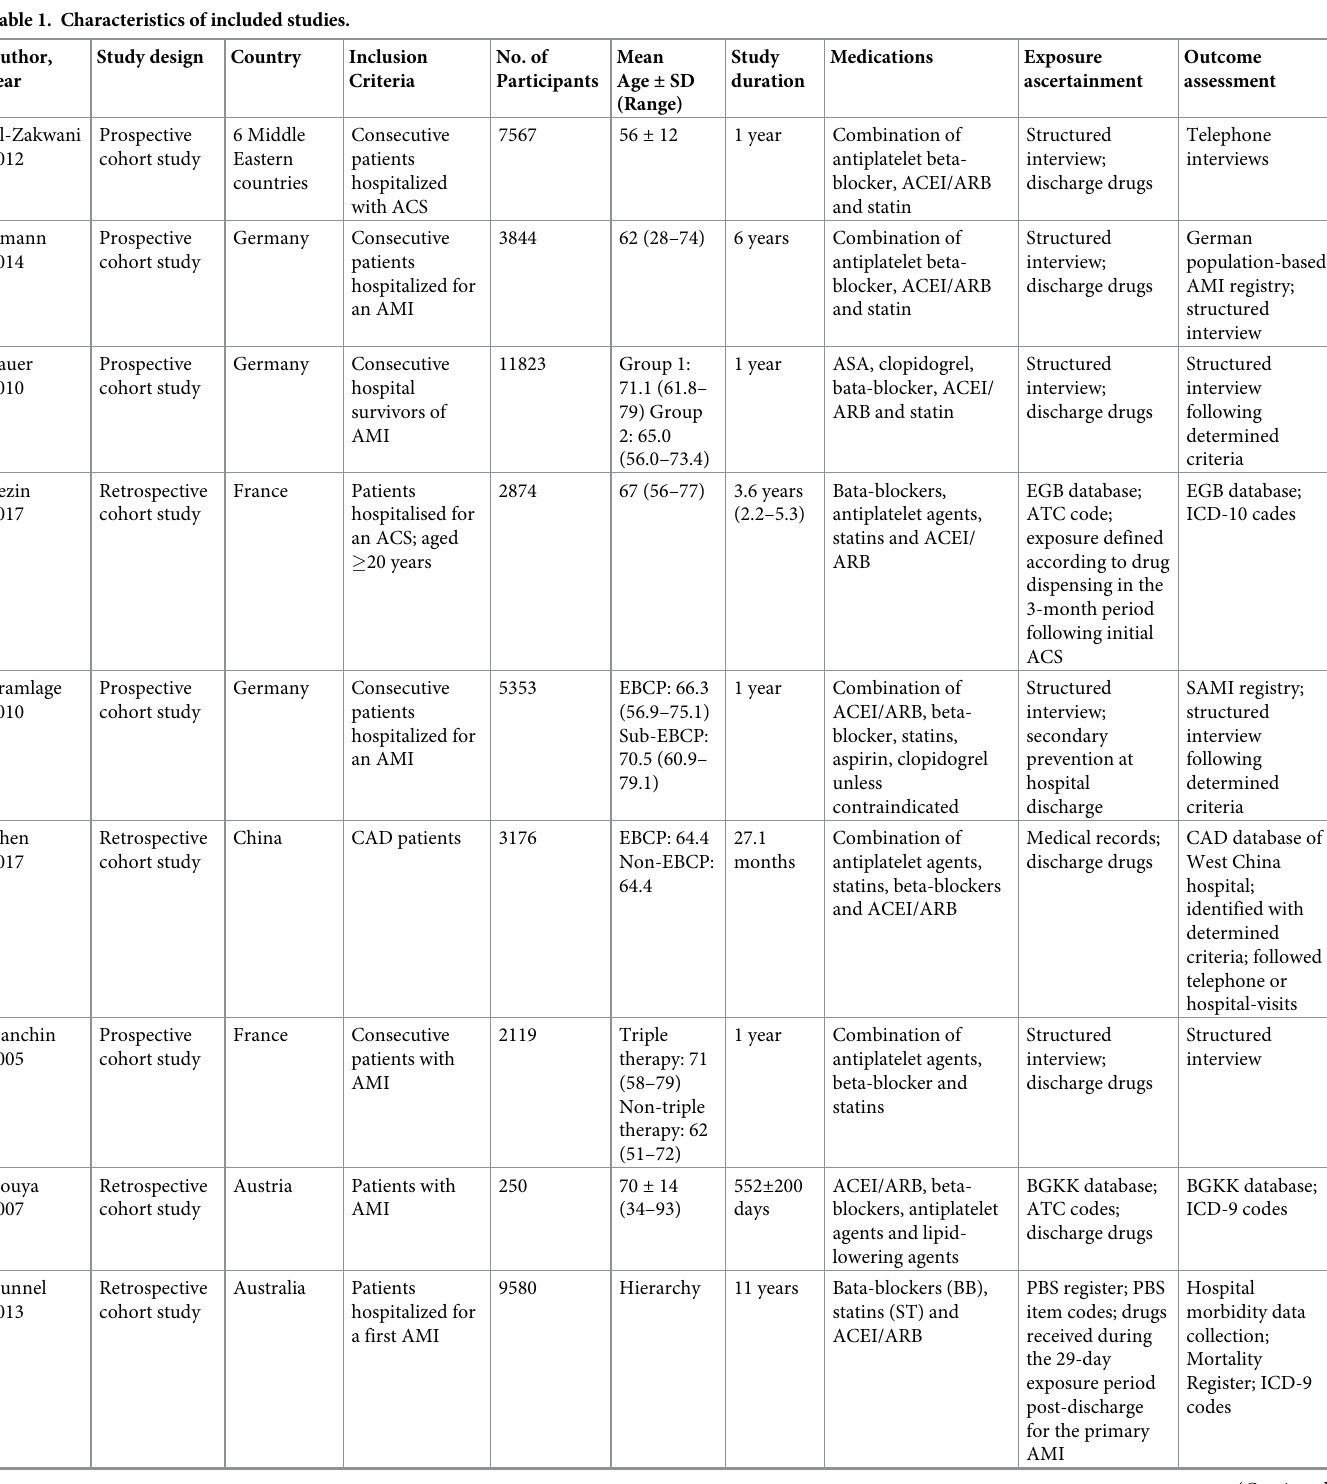
Table 1. Characteristics of included